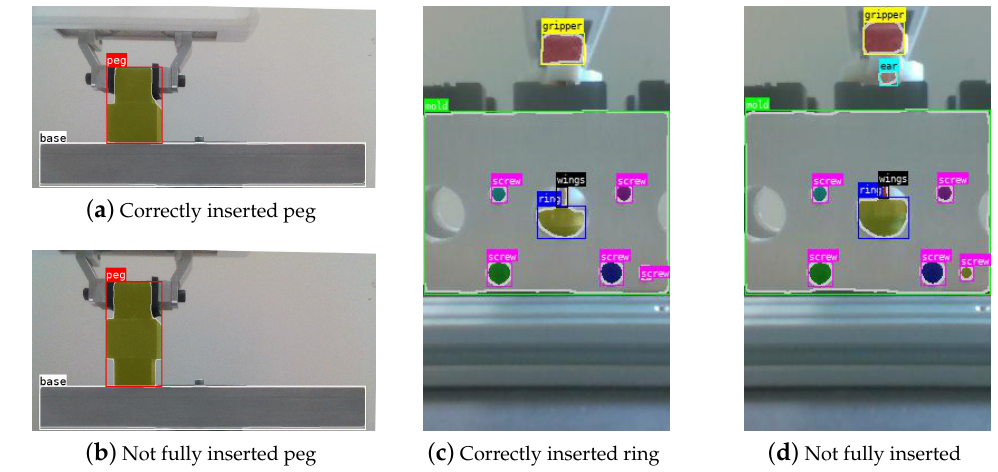
Figure 8. Bounding boxes and masks obtained by YOLACT using snapshots of the outcome of both tasks as input. For the PiH task ( a , b ), the base plate and peg are detected, regardless of the position/occlusion of the latter. In the copper ring insertion task ( c , d ), the gripper, mold, screws, ring base, wings, and ears are detected. Notice that ears are only detected when the part is not fully